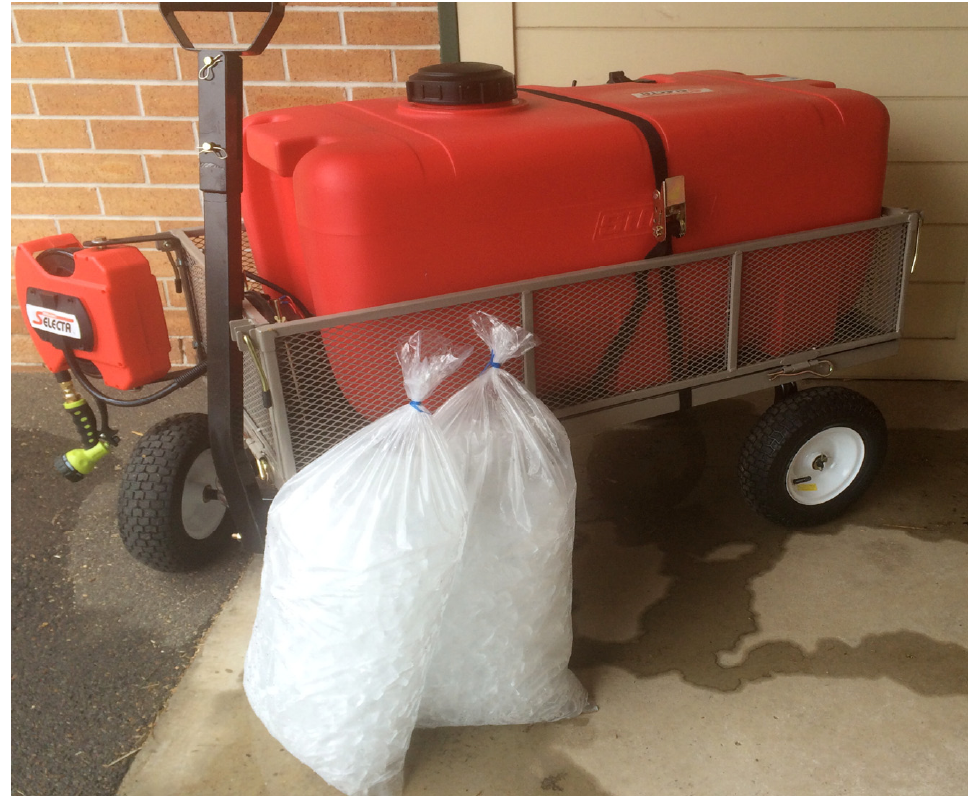
Figure 21. A compact, mobile cooling device. The design could be improved by the inclusion of an insulating blanket to decrease ice loss in the hot summer months and a wider filler neck to admit solid ice more easily.